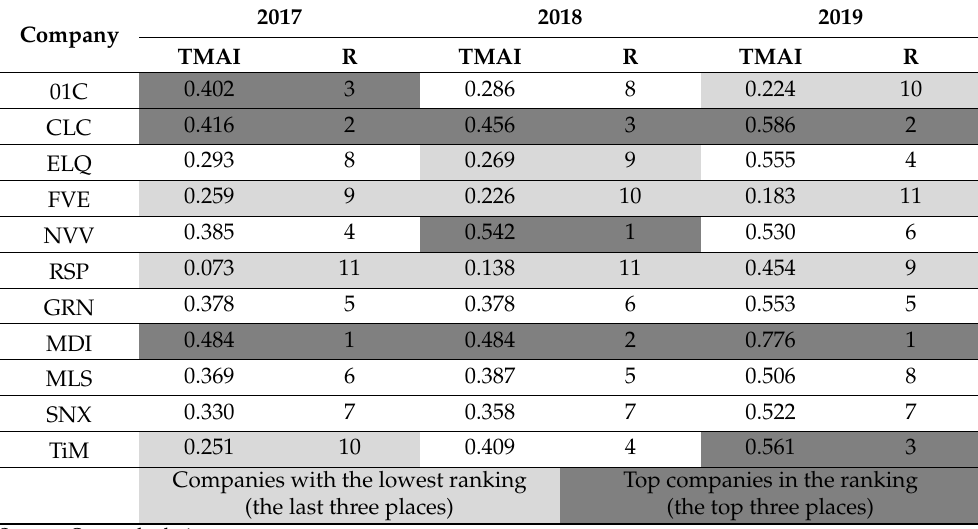
Table 6. Ranking of companies based on the TMAI in